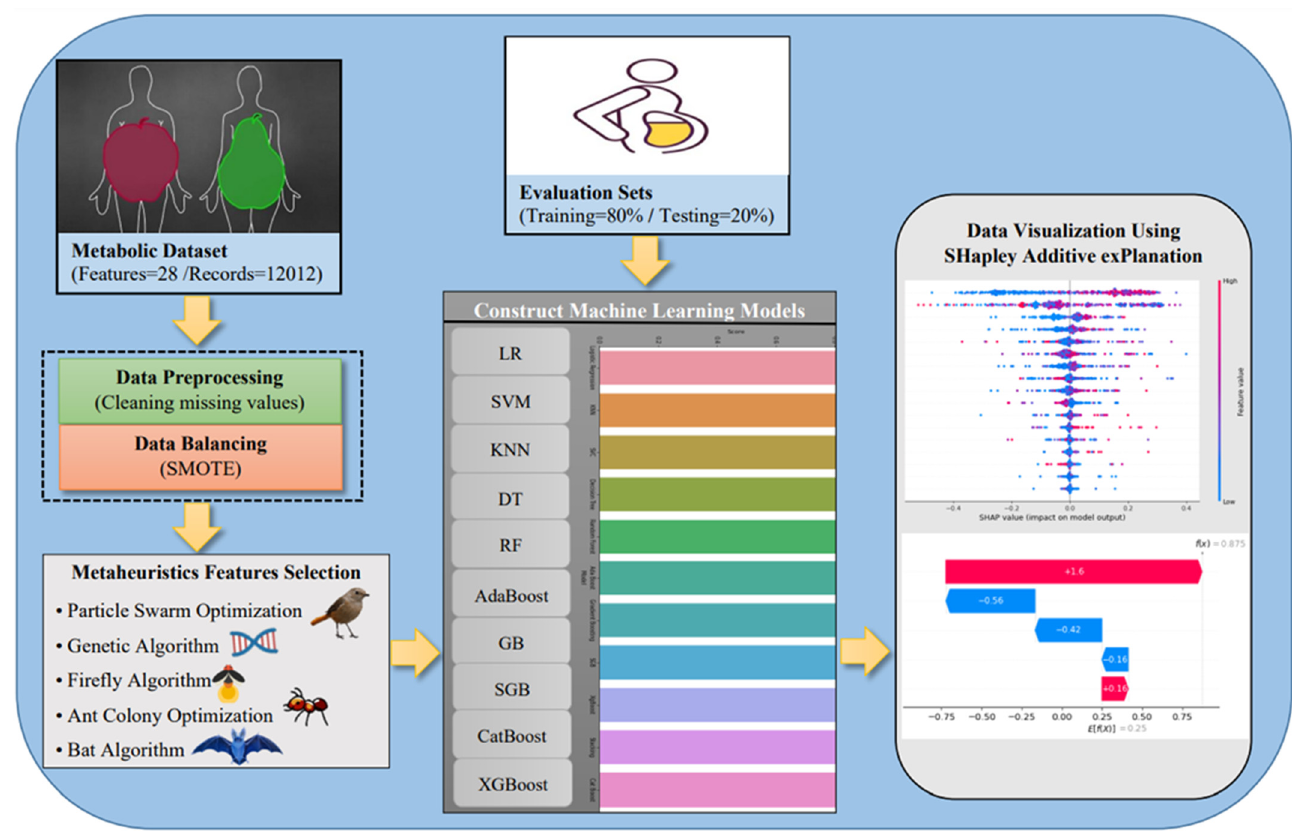
Figure 2. An overview of the proposed framework for metabolic data